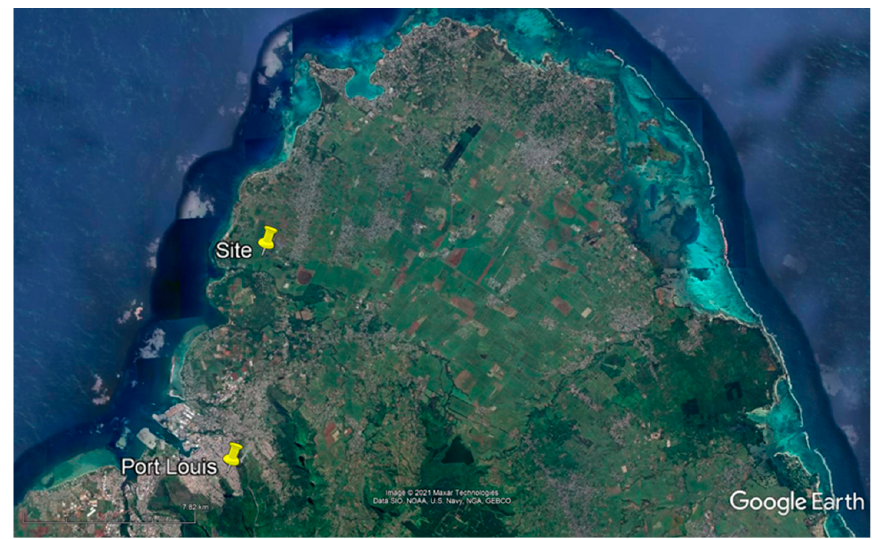
Figure 3. Site location and northern part of Mauritius island [33].